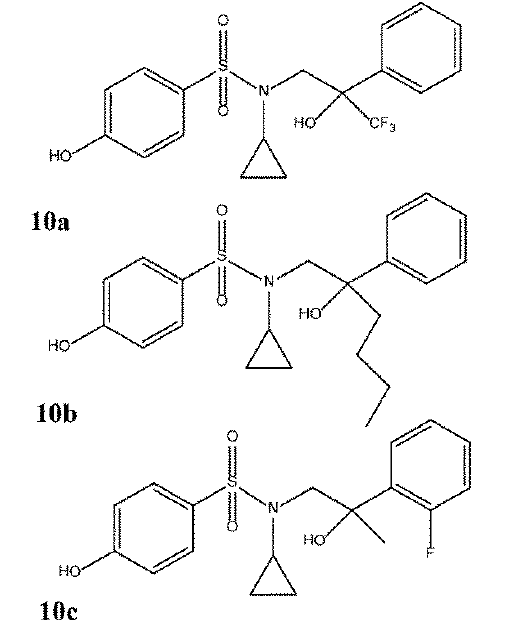
Figure 9. Analogues of ERβ selective compound 10